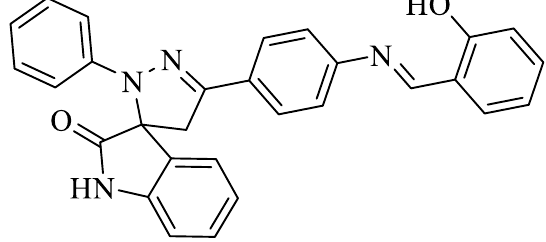
Fig. 4. Isatin derivatives as anti-cancer activity (Fayed et al.,